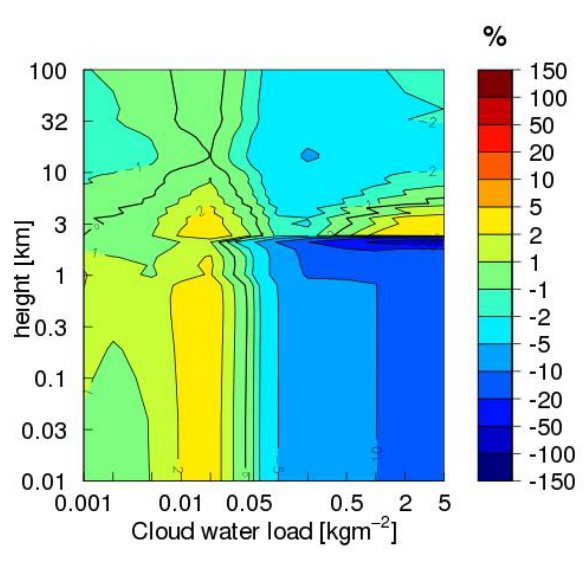
Figure 13. As for Fig. 11 but for IFS-Nielsen vs.